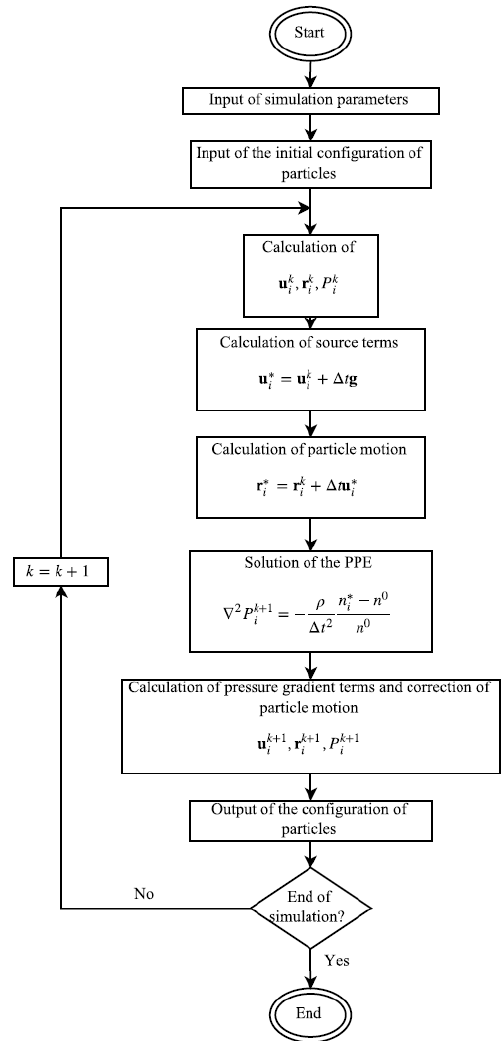
Fig. 5: Algorithm of MPS method